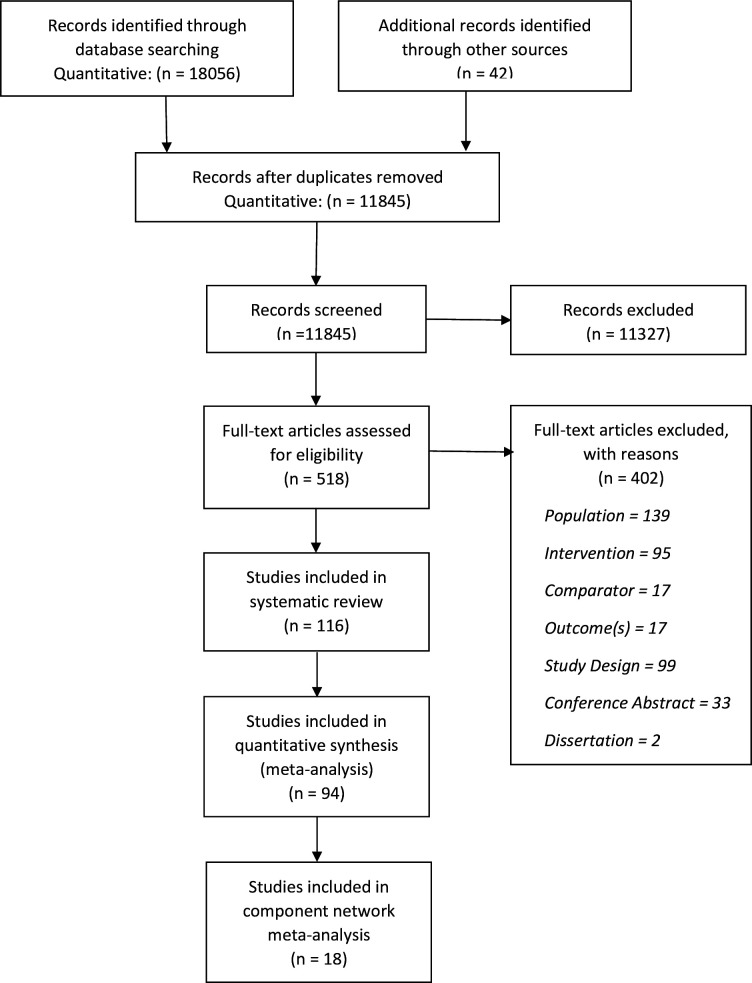
PRISMA flow diagram.